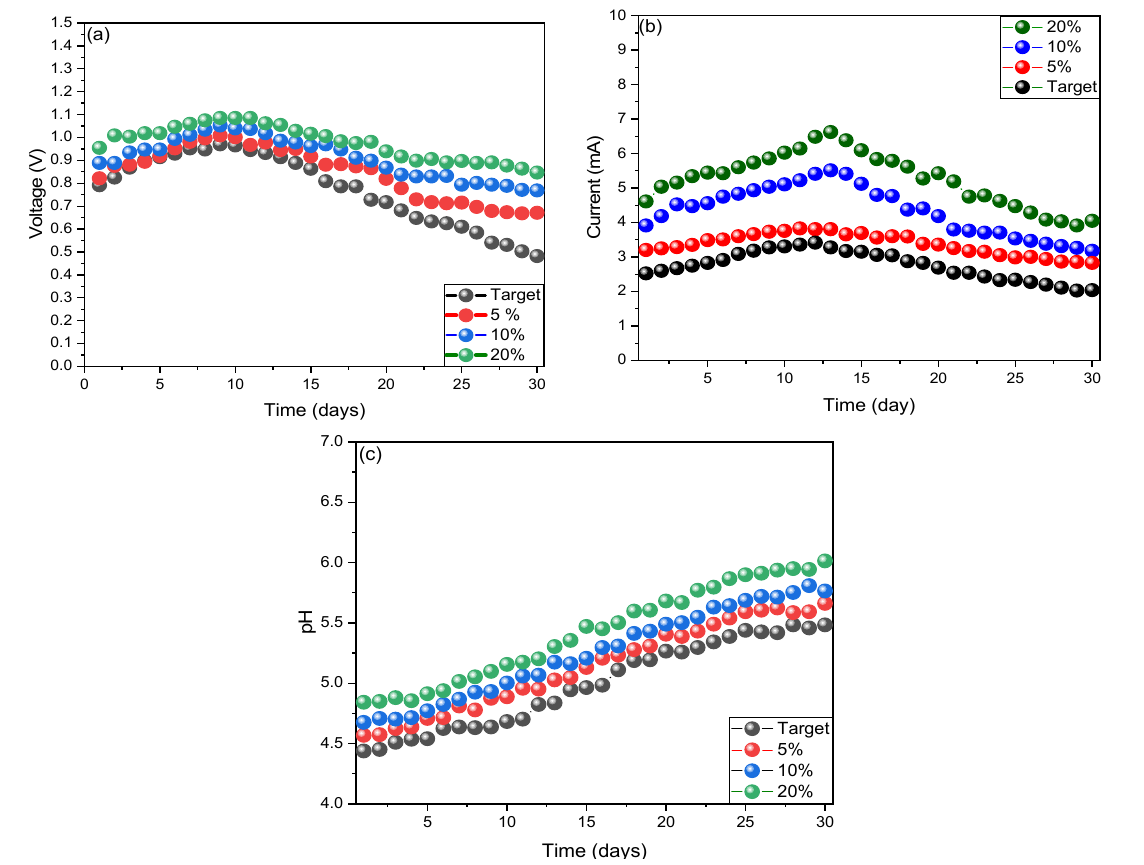
Figure 2. Values of ( a ) voltage, ( b ) electric current, and ( c ) pH obtained from the monitoring of the microbial fuel cells during 30 days.